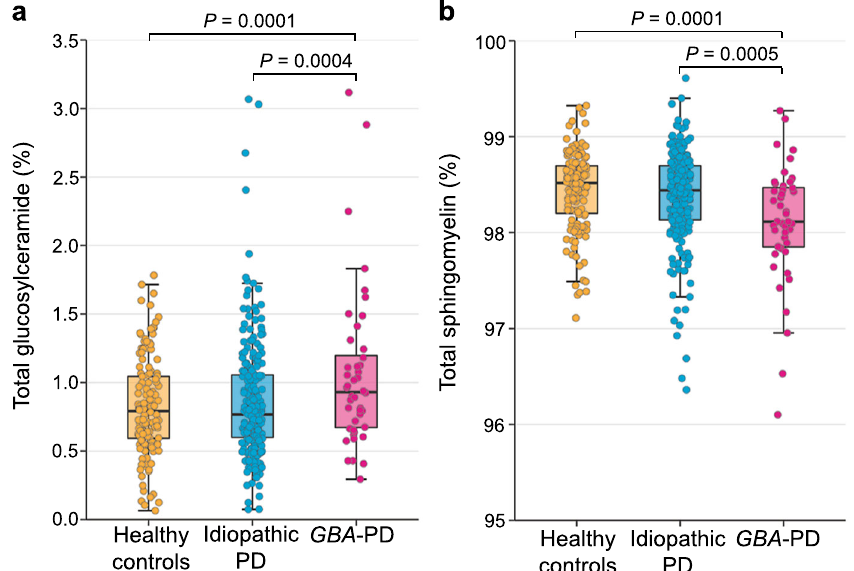
Fig. 1 Glucosylceramide and sphingomyelin in cerebrospinal fl uid (CSF) of GBA -PD patients compared to idiopathic PD patients and healthy controls. a The glucosylceramide fraction was signi fi cantly higher in GBA -PD patients compared to idiopathic PD patients and healthy controls adjusting for covariates. b The sphingomyelin fraction was signi fi cantly lower in GBA -PD patients compared to idiopathic PD patients and healthy controls controlling for covariates. Unadjusted sphingolipid fractions in CSF are shown in box and jitter dot blots; box plots indicate the median (bold line), the 25th and 75th percentiles (box edges), and the most extreme data point no more than 1.5x the interquartile range from the box (whiskers). The P -values are from linear mixed model analyses adjusting for covariates.